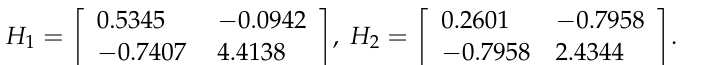
t x with σ = 0.014. 1